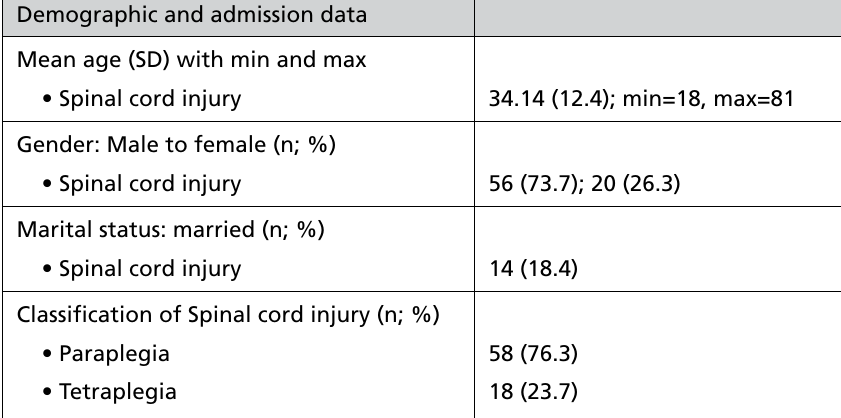
table 1: Demographic data of the participants with spinal cord injury (n=76) Demographic and admission